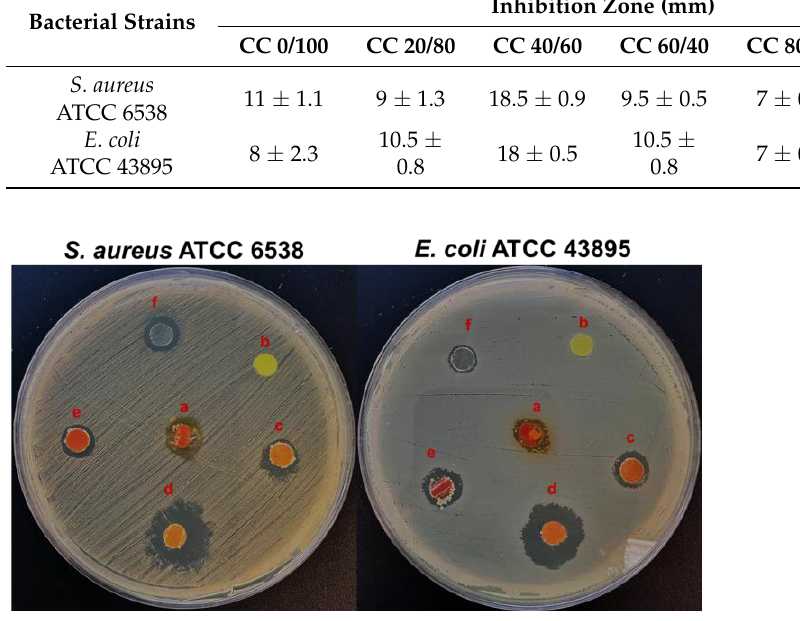
Figure 6. Antimicrobial activities of Ch/Poly (C-fu) blends with different C-fu contents: (a) 100%, (b) 80%, (c) 60%, (d) 40%, (e) 20%, and (f) 0%. Visible clear zones were produced by polybenzoxazine films against S. aureus and E. coli .